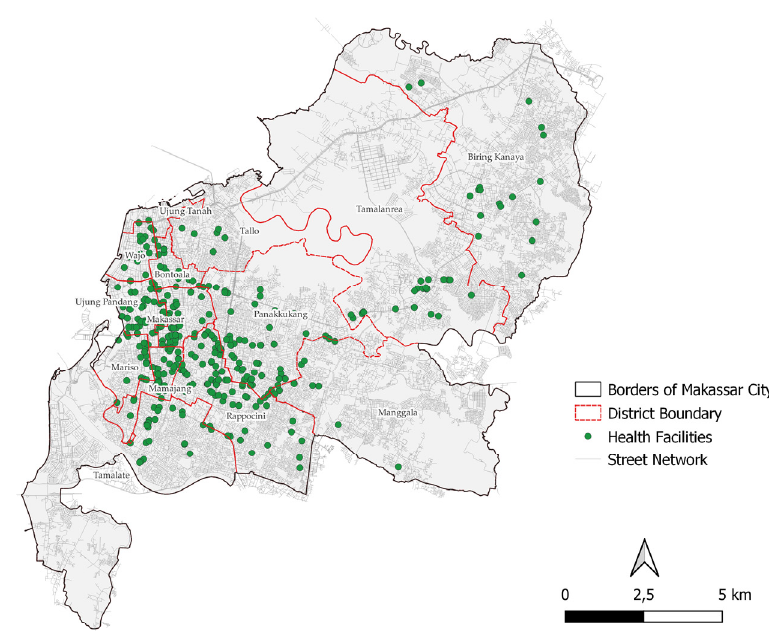
Figure 2. Distribution of Health Facilities in Makassar City. Table 3. Distribution of Health Facilities in Makassar City.